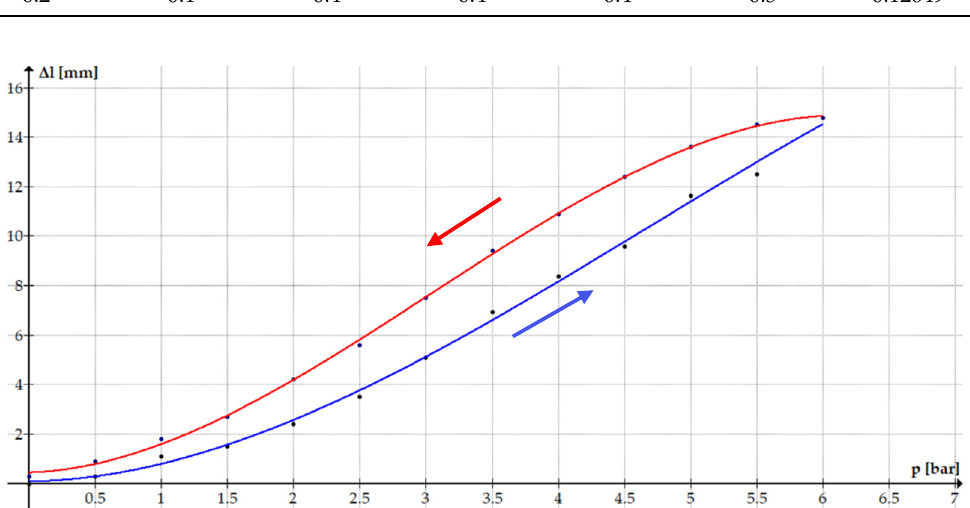
Figure 7. Evolution of axial contraction versus pressure (M = 2.55 kg).